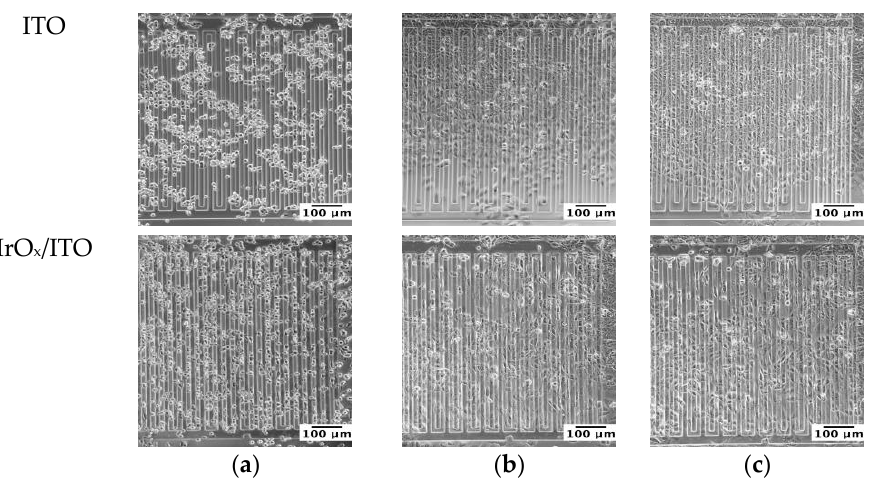
Figure 1. Phase contrast micrographs of ITO and IrO x coated ITO electrodes for various breast cancer cell coverage ratios ( a ) 65%; ( b ) 88%; and ( c ) 92%.